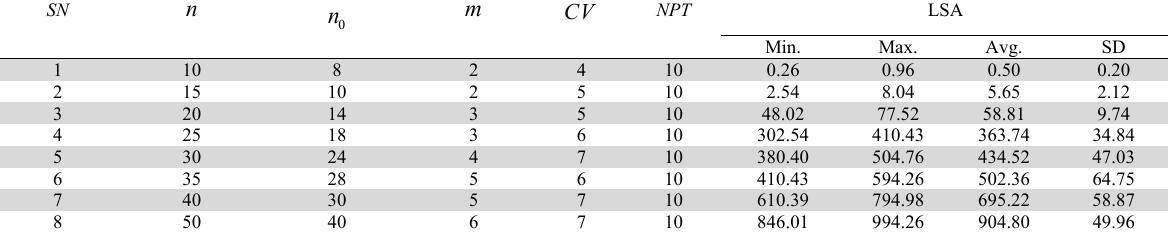
Descriptive statistical results of CPU runtime of LSA on random